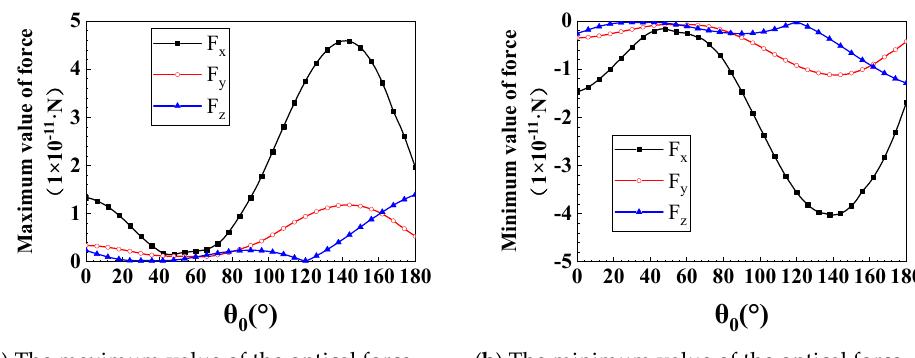
θ . ( a ) and ( b ) show the θ F F F , y , and z in the process of 0